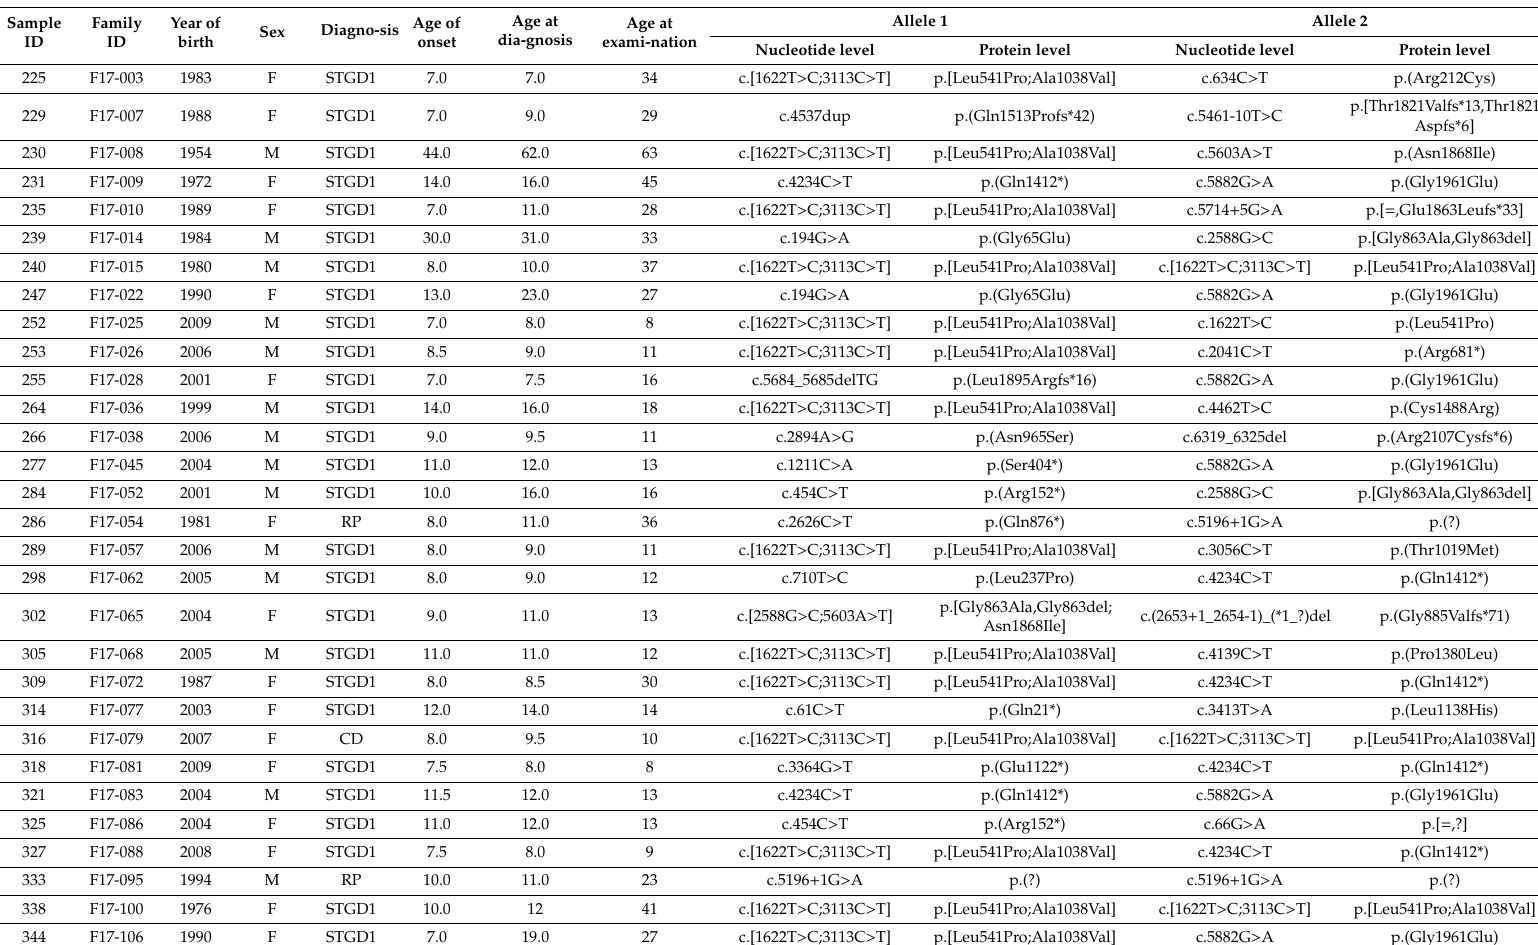
Table 1. Genetic and demographic data of patients su ff ering from retina-specific ATP-binding cassette transporter 4 ( ABCA4 )-related disorders. CD = cone dystrophy; CRD = cone-rod dystrophy; RP = retinitis pigmentosa; STGD1 = Stargardt’s dsease type